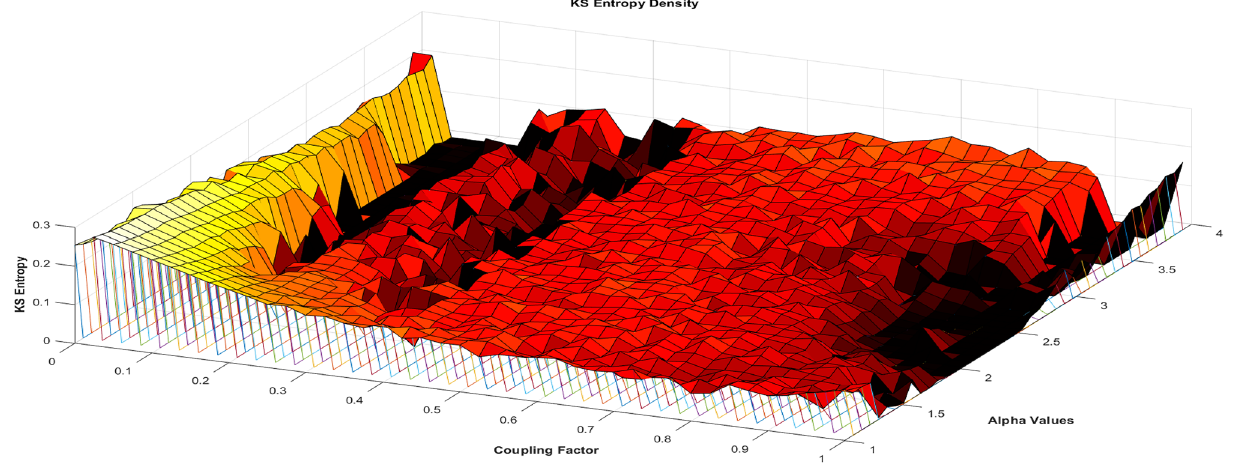
Fig. 7 Shows KS entropy density plot for CML system with GSM and adaptive 𝛽 for the set parameters ( 1 ≤ 𝛼 ≥ 4 , 0 ≤ 𝜖 ≥ 1 , 𝛽 = adaptive, N = 10 and 𝛾 = 0.25)